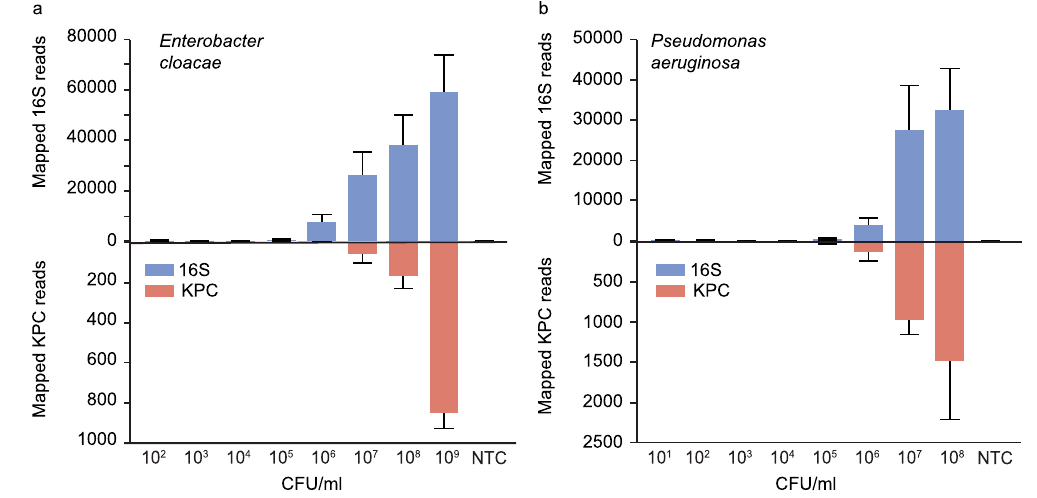
Figure 4. Detection of AR and 16S gene sequences from blood culture matrix. Pooled 16S and KPC MIPs were tested against DNA extracts prepared from serial-dilutions of blood culture matrix spiked with ( a ) Enterobacter cloacae and ( b ) Pseudomonas aeruginosa at concentrations ranging from 10 9 –10 1 CFUs/ml. Total reads mapped to 16S references, upper Y-axis, and KPC references, lower Y-axis, are shown for each dilution. Error bars represent the standard deviation of three independently extracted